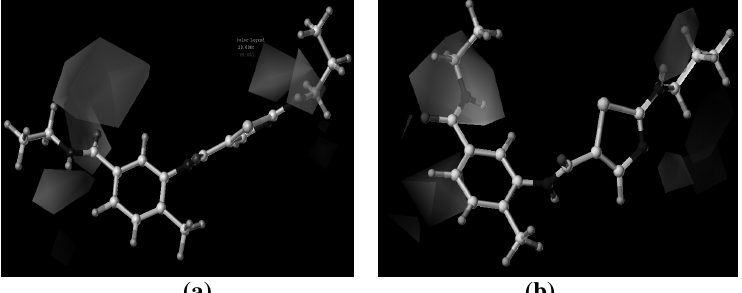
Figure 8 CoMSIA S.D. * coefficient contour maps illustrating acceptor and donor features in combination with compound 2g. a) Ligand based and (b) Receptor based. The purple contour for H -bond acceptor group increases activity, cyan indicates the disfavored region; the orange and blue contours represent favored and disfavored hydrogen bond donor groups respectively